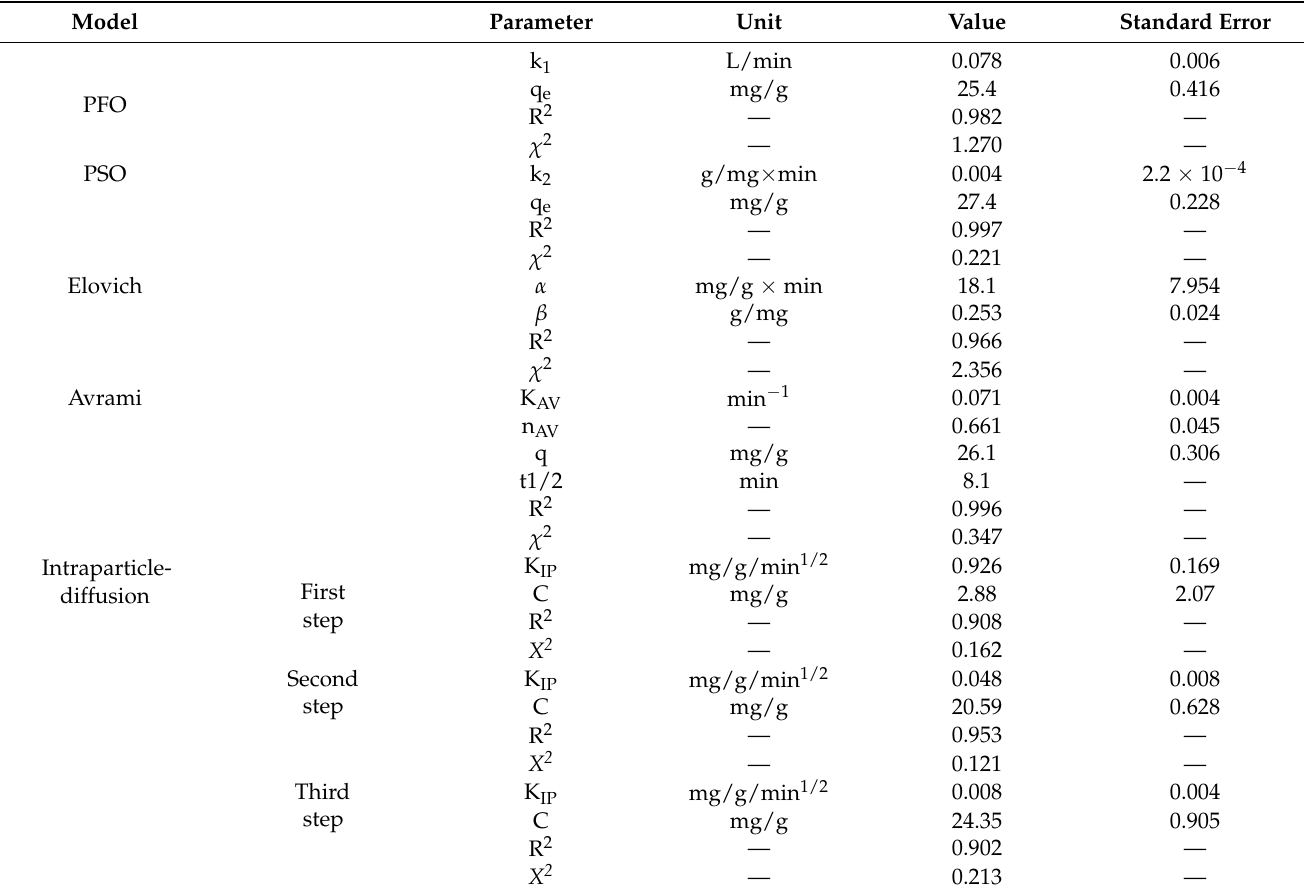
Table 4. Kinetic parameters of CV dye adsorption onto DSD material at C 0 = 30 mg/L. Model